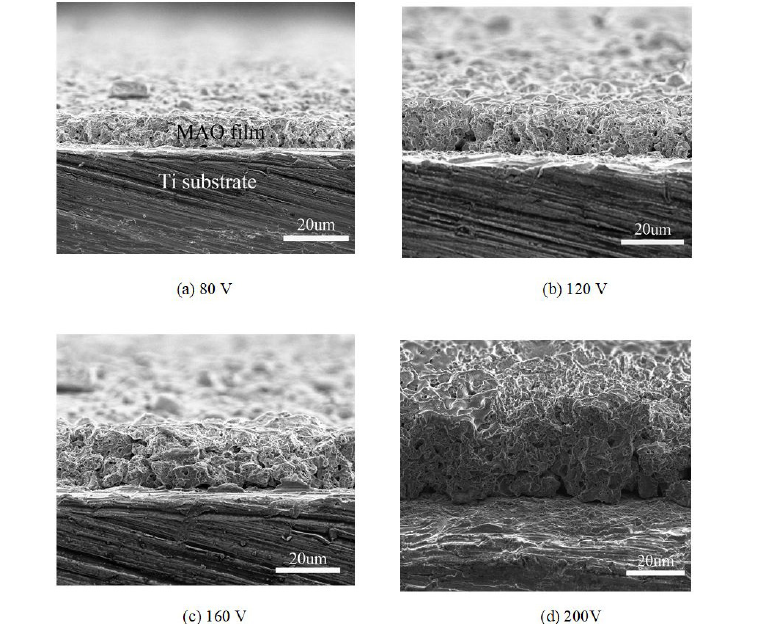
Figure 5. SEM of the MAO coating intersecting surface, for various voltages (a) 80 V, (b) 120 V, (c) 160 V, (d) 200 V.